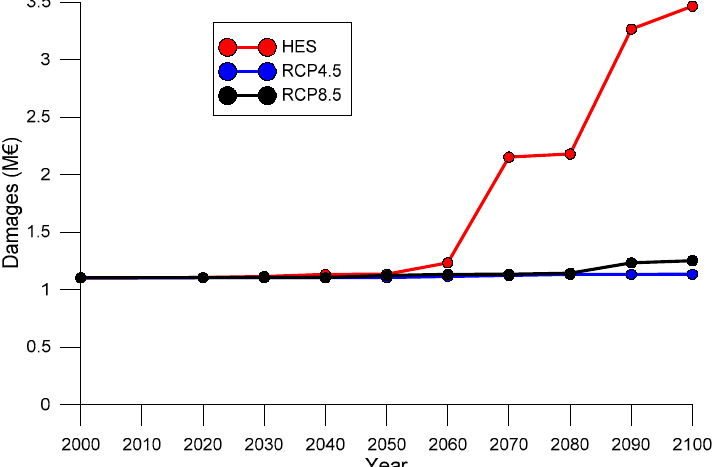
Figure 6. Estimation of damages (in millions of euros) in Catalan ports due to overtopping for the three SLR scenarios and for a return period of 50 years.